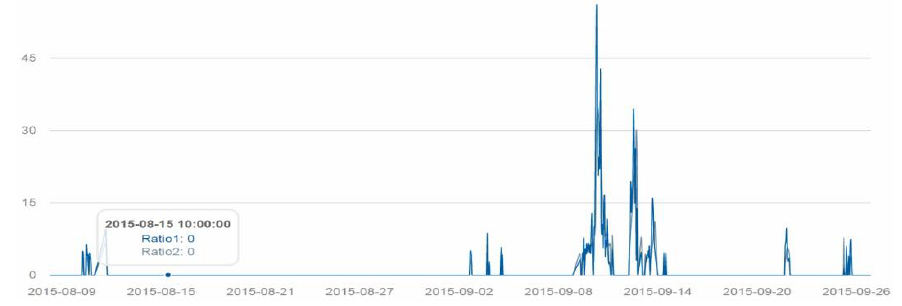
Figure 4. Temporal spectrum of rain-related tweets between 8 August and 27 September. Ratio1 represents the one hour interval ratio while Ratio2 represents the five hour interval ratio.